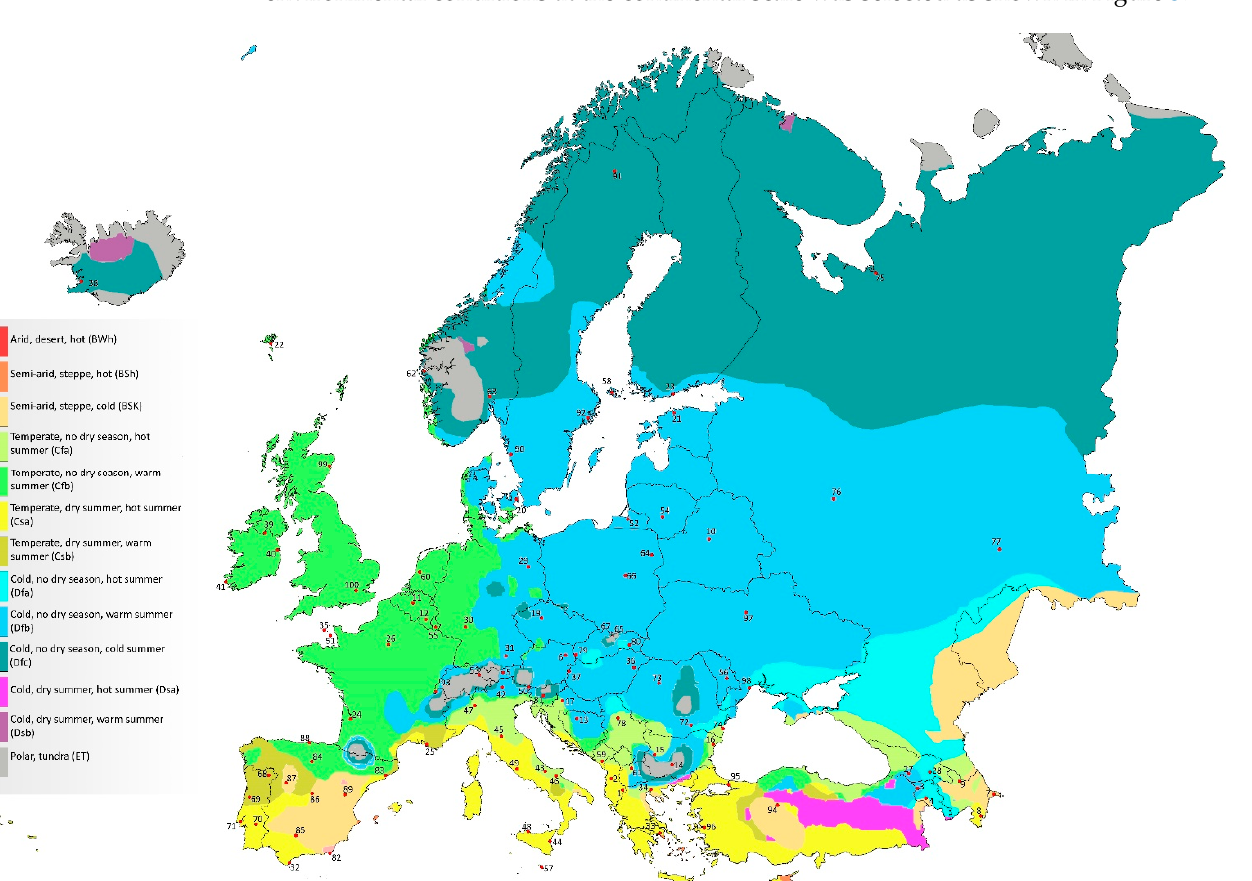
Table 1. Heating and cooling degree-days, yearly average temperature and identification for the 100 selected locations in Europe sorted by country and climate type (darker colours means higher HDD/CDD values).